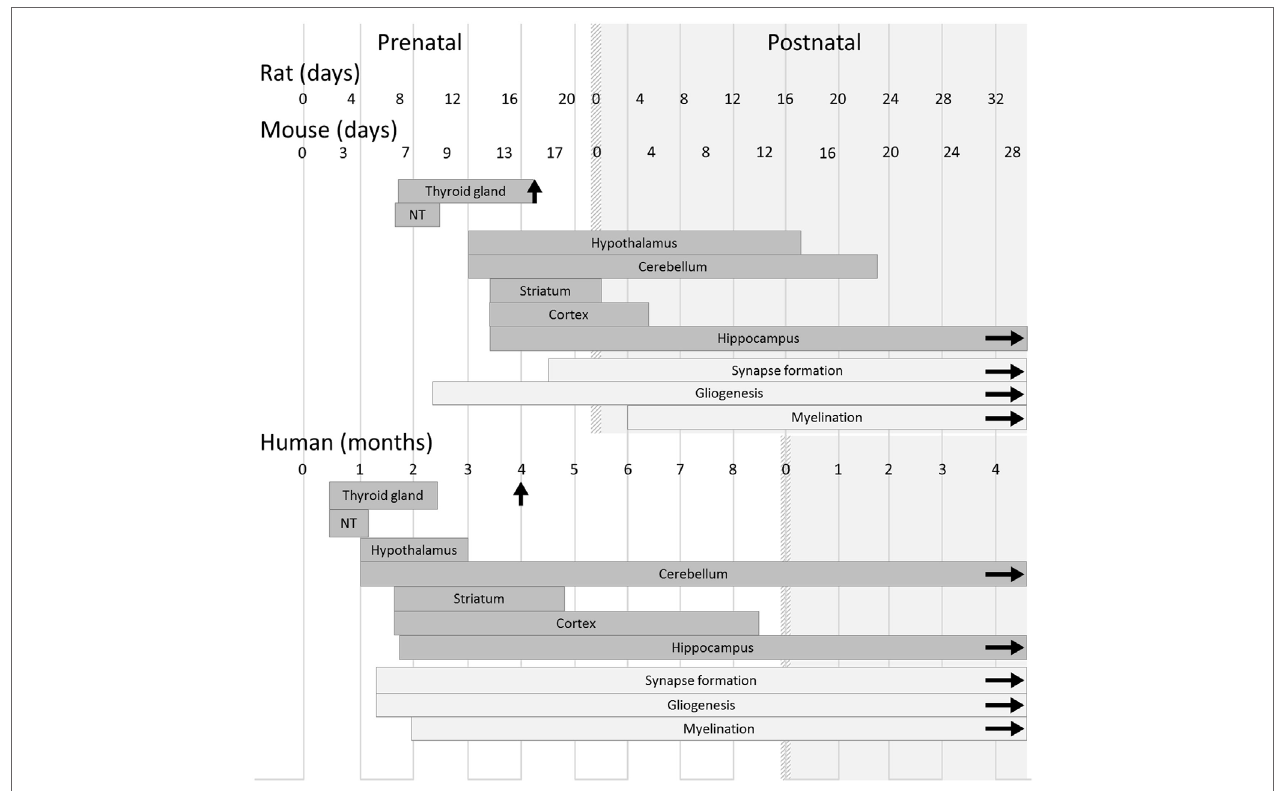
FiGURe 1 | Timeline of thyroid and brain development in humans and rodents. In both rodents and humans, the development of the main brain areas starts before the onset of the fetal thyroid gland function and relies on maternal thyroid hormone supply. However, differences between species must be kept in mind when translating results from rodent models to humans, and even between mouse and rat models. Gestation lasts 22 days in rats, 19 days in mice, and 42 weeks in humans. Gliogenesis, myelination, and synaptogenesis are asynchronous in different brain areas and continue after birth. For each brain region, the corresponding rectangle symbolizes the phase of neurogenesis. Vertical arrows indicate the initiation of iodide uptake by thyrocytes, which marks the end of thyroid gland maturation. The light gray area corresponds to postnatal life. Abbreviation: NT, neural tube [adapted from Ref.